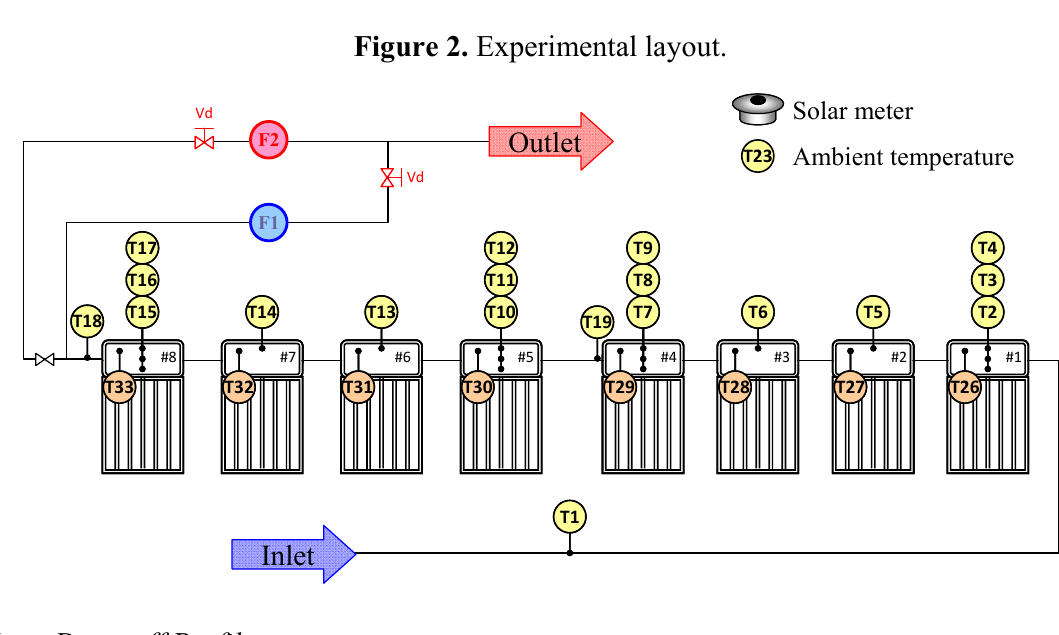
Figure 2. Experimental